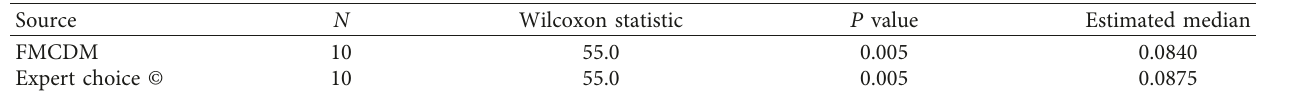
Figure 3: Expert Choice results vs FMCDM model results (case two). Table 8: Activity duration and